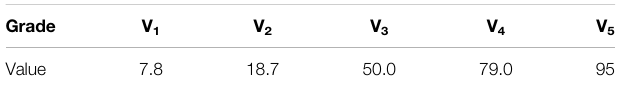
TABLE 2 | Comprehensive evaluation results based on the entropy weight method.